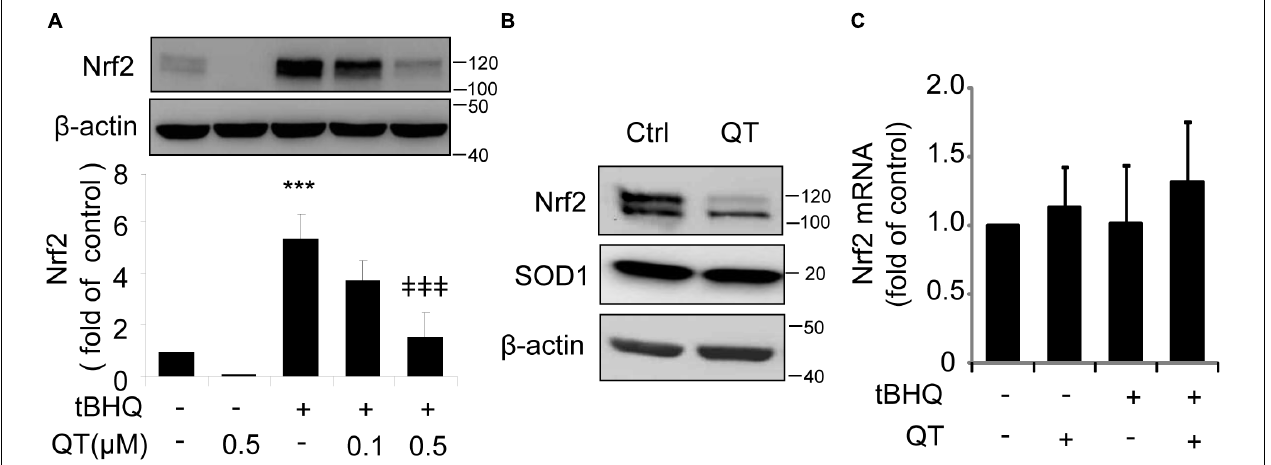
FIGURE 5 | Quinotrierixin abolishes tert-Butylhydroquinone induced Nrf2 upregulation. (A–C) ARPE-19 cells were treated with tert-Butylhydroquinone (tBHQ) (10 µ M) in the presence or absence of QT for 8 h. Nrf2 and SOD1 protein levels were detected by Western blot analysis (A,B) (mean ± SD, n = 3, ∗∗∗ p < 0.001 vs. control, ‡‡‡ p < 0.001 vs. tBHQ treated cells); Nrf2 mRNA level was detected by real-time PCR (C)